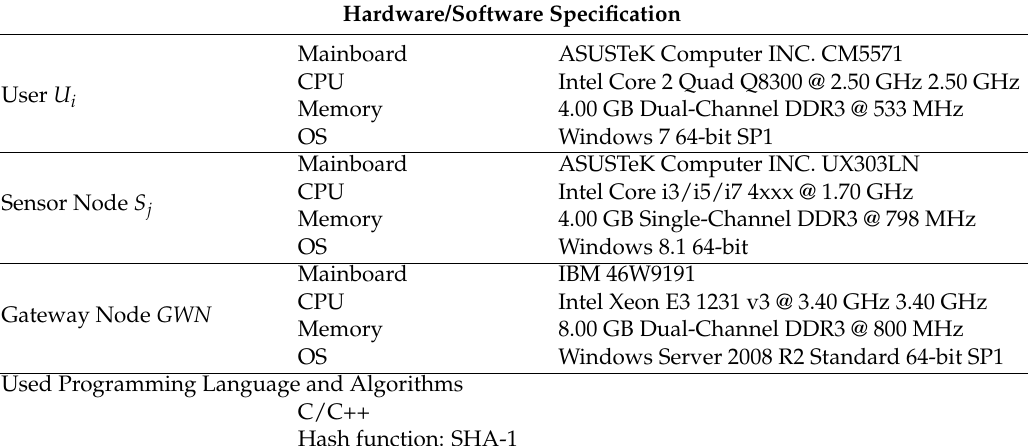
Table 4. Simulation